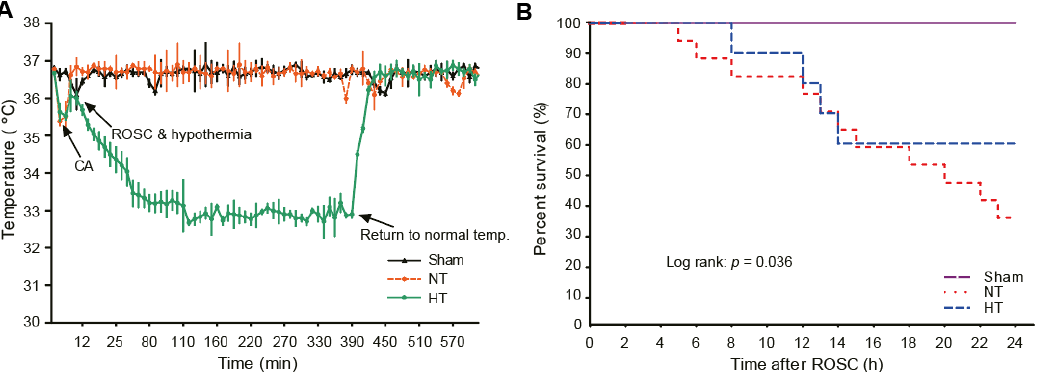
Figure 2. Olanzapine-induced TH improves overall survival in CA-induced rats. ( A ) Body temper- ature changes after the induction of CA. ( B ) The survival rate in rats after CA and ROSC with or without olanzapine-induced TH based on Kaplan–Meier analysis. TH, therapeutic hypothermia; CA, cardiac arrest; ROSC, return of spontaneous circulation; NT, normothermia; HT, hypothermia.